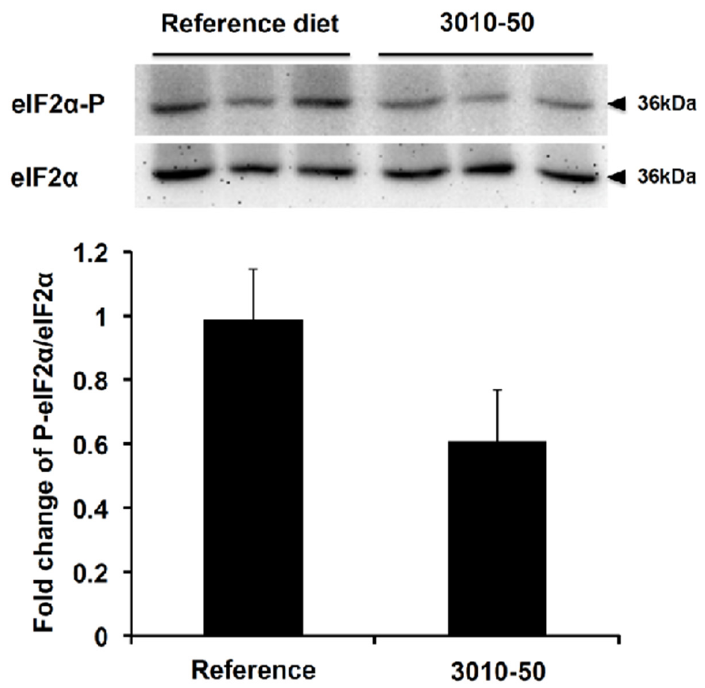
Figure 7. Comparison of eIF2 α phosphorylation in liver extracts from cobia juveniles fed a reference diet versus a diet with soy protein concentrate using the non-GMO soybean cultivar 3010. Juvenile cobia fed with either a reference diet (formula given in Table S3) or a diet with partial replacement of fish meal, poultry by-product (reference diet), and soy protein concentrate with a non-GMO soy- bean cultivar (3010-50). Proteins in tissue extracts were fractionated by SDS-PAGE and transferred to PVDF. Phosphorylated and total eIF2 α were visualized by enhanced chemiluminescence, using an antibody to phosphorylated eIF2 α and (after stripping) antibodies to total eIF2 α , as described in the legend in Figure 4. Values obtained for phosphorylated eIF2 α were normalized for the total level of eIF2 α present in the sample and expressed as the relative density of phosphorylated to total eIF2 α , with the bar diagrams in lower panels corresponding to the respective lanes in the upper panel. 3.8.3. eIF2 α Phosphorylation during “Cold Banking” and Acclimation “Cold banking” is a carefully employed technique to slow down the fish growth rate. It is especially effective with fingerlings when an investigator tries to stagger fish produc- tion. A comparison was made of “cold banked” juveniles, maintained at 20 °C and fed a maintenance ration equivalent to 1.5% body weight (bw) daily, five days a week, for six weeks prior to acclimation with cold-banking parameters based on Holt et al. [5] Acclima- tion to 27 °C and 5% bw daily feeding was established over two weeks, with temperature increasing 1 °C per day and 0.5% bw per day for one week, followed by maintenance at 27 °C and 5% bw daily feeding for one week. eIF2 α phosphorylation was compared in the cold-banked and acclimated fish in Figure 8. eIF2 α phosphorylation was higher in the fish